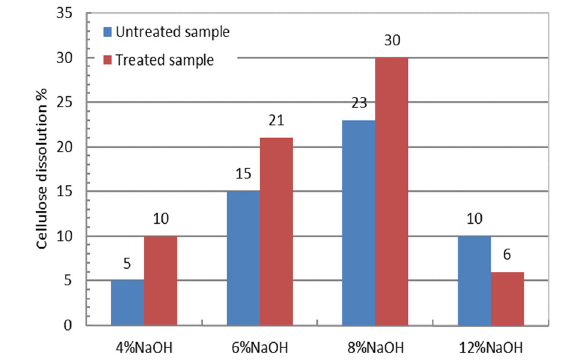
Fig. 5. Percentage of cellulose dissolution at different NaOH weight concentrations at temperature - 15 ±2 o C.